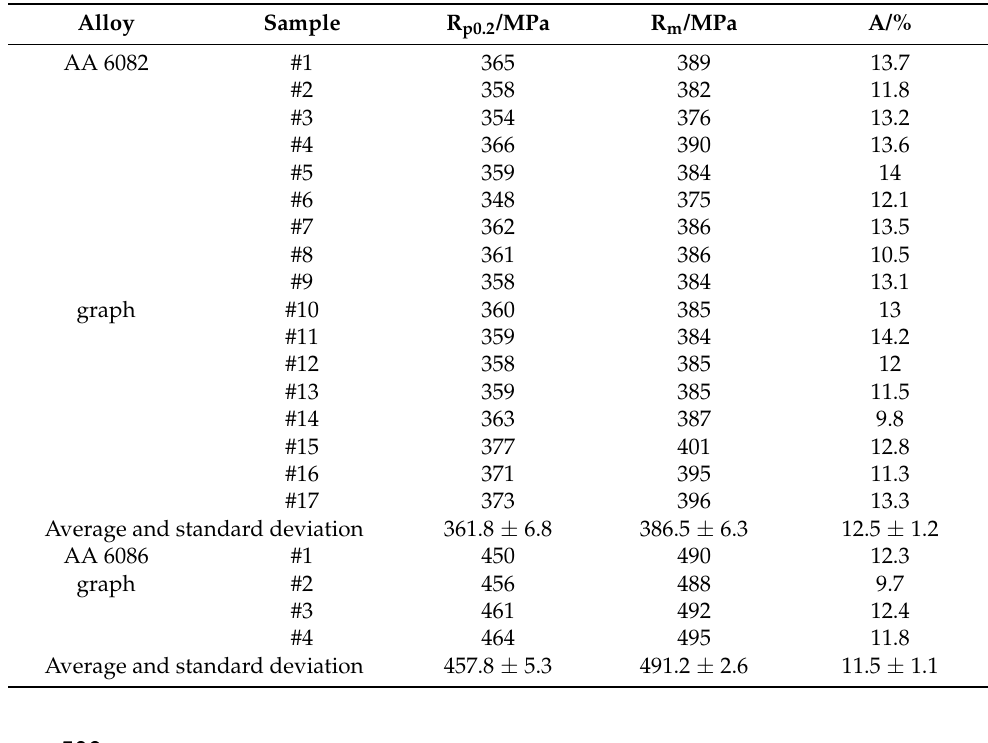
Figure 12. The transmission electron micrographs of the alloy after T6 temper, shoving precipi- tates. ( a ) Bright-field micrograph and ( b ) HAADF micrograph. Table 3. Comparison of tensile properties of AA 6082 (average values and standard deviations for 17 samples) and AA 6086 (average values and standard deviations for 4 samples).